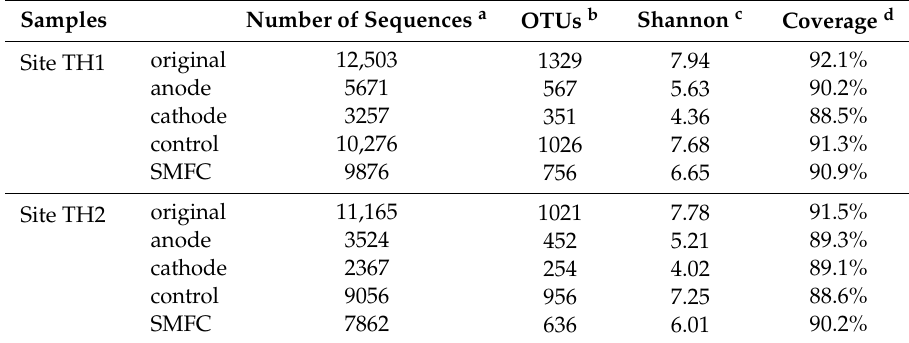
Table 1. Observed bacterial richness and diversity estimated based on 97% OTUs clusters for sediments under di ff erent